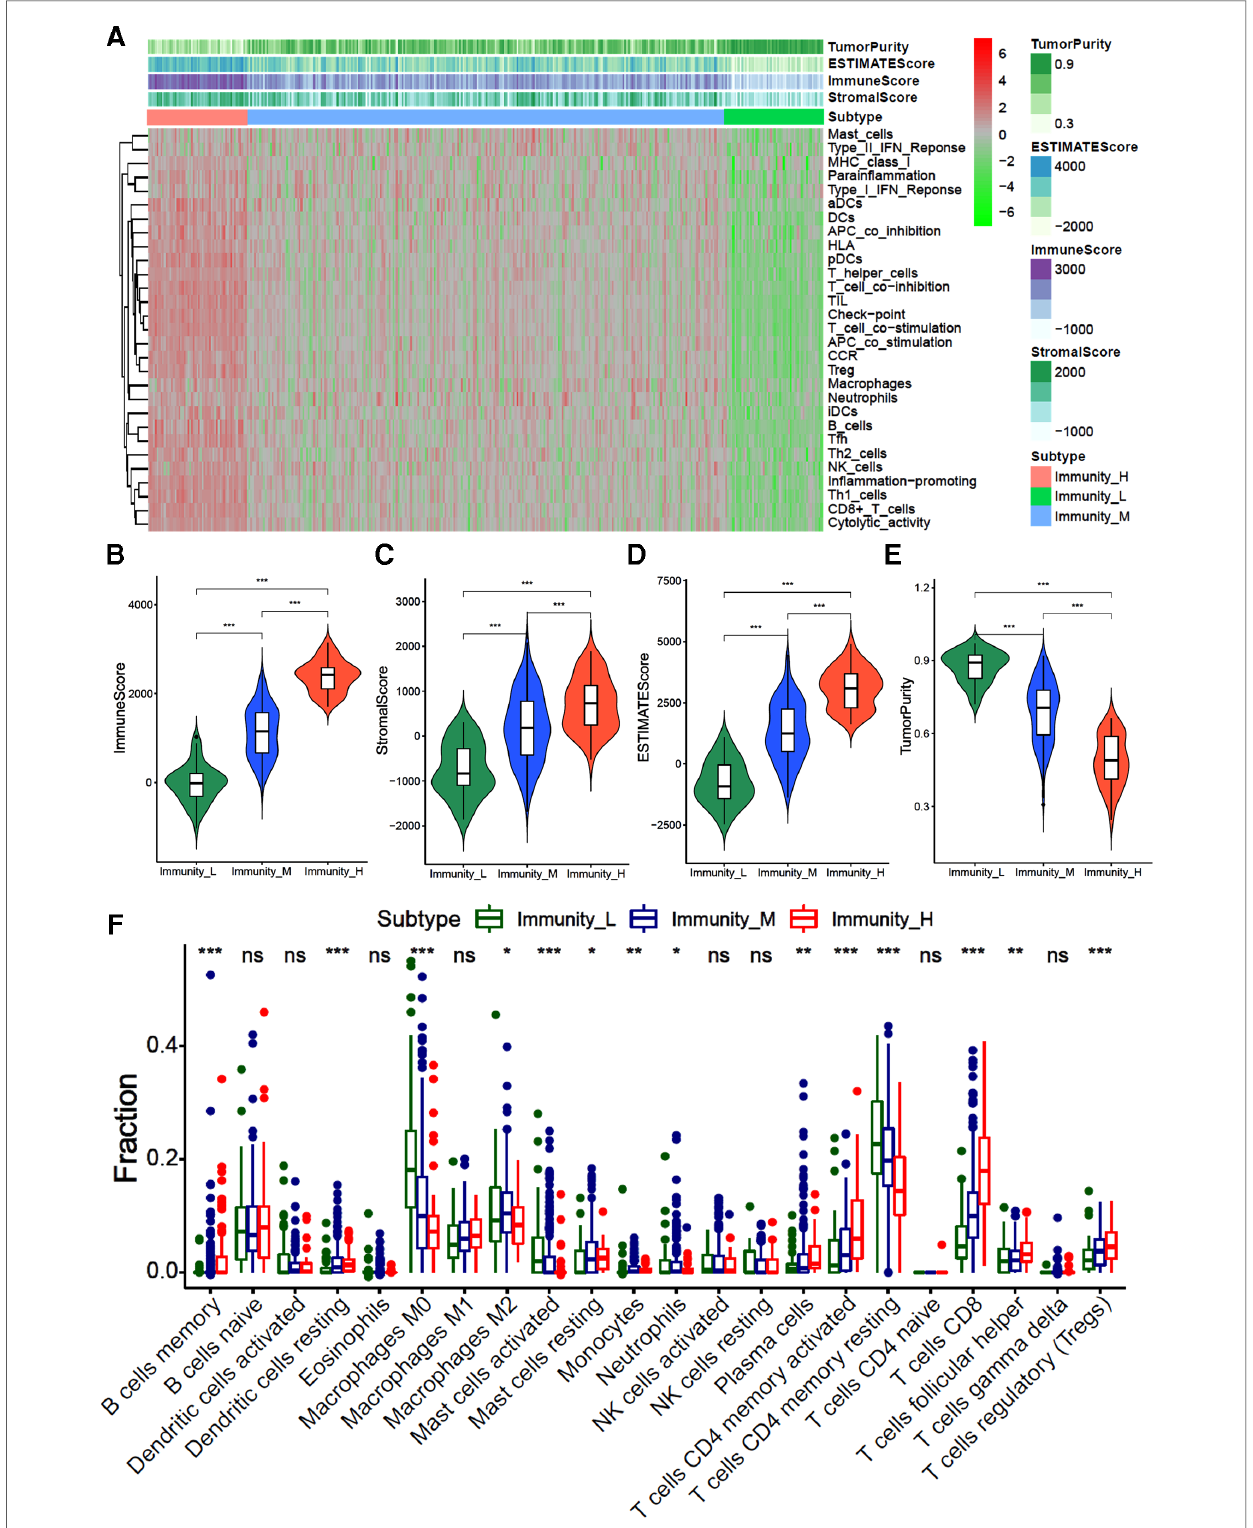
FIGURE 1 Hierarchical cluster analysis of gastric cancer based on 29 immune-related gene sets ( A ) the heatmap of 29 immune-related gene sets ssGSEA score; ( B – D ). The violin diagram of difference between immunity-H, -M and -L subtypes of gastric cancer in stroma score ( A ), immune score ( B ), total ESTMATE score ( C ) and tumor